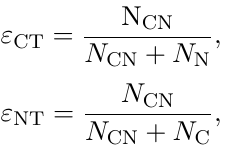
Figure 5 . cos (cid:18) (cid:17) distribution for the experimental data (points with error bars) and simulated e + e (cid:0) ! (cid:17)(cid:25) + (cid:25) (cid:0) events (histogram) in the energy range of the (cid:17)(cid:26) (770) intermediate